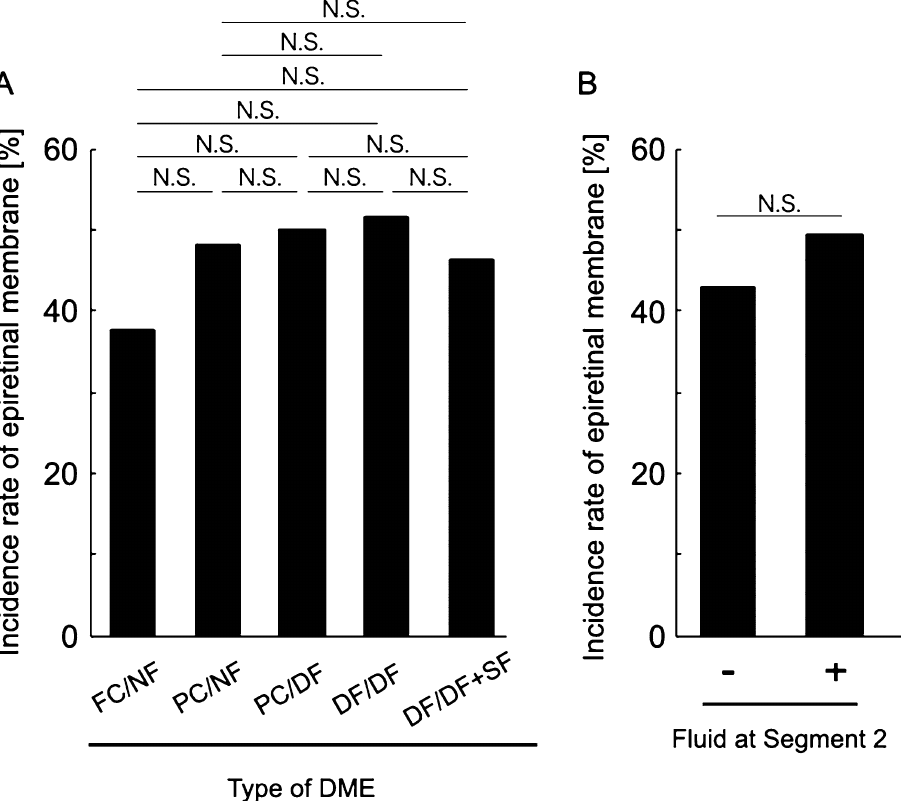
Figure 9. Relationship between the incidence of epiretinal membrane (ERM) and the en face image-based classification of diabetic macular edema (DME). ( A ) The incidence of ERM is compared among the DME types. ( B ) The incidence of ERM is compared according to the presence or absence of fluid at Segment 2. DME diabetic macular edema, FC/NF foveal cystoid space/no fluid type, PC/NF parafoveal cystoid space/no fluid type, PC/ DF parafoveal cystoid space/diffuse fluid type, DF/DF diffuse fluid/diffuse fluid type, DF/DF + SF diffuse fluid/ diffuse fluid with subretinal fluid type, N.S. not